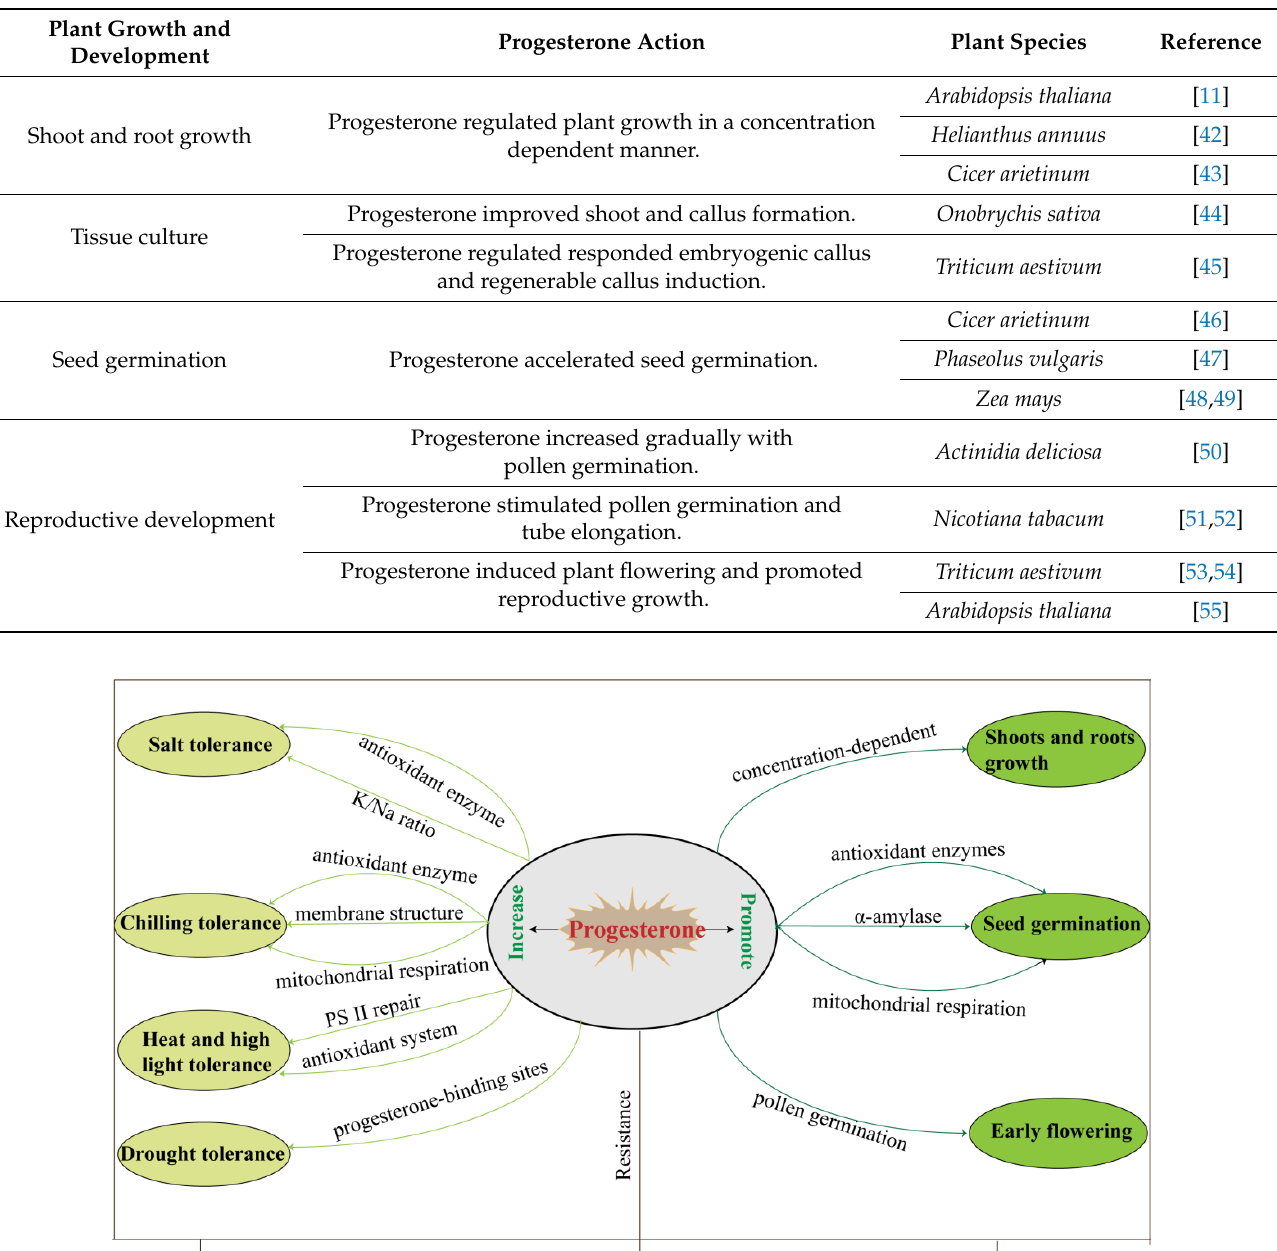
Table 1. The regulation of progesterone on plant growth and development.